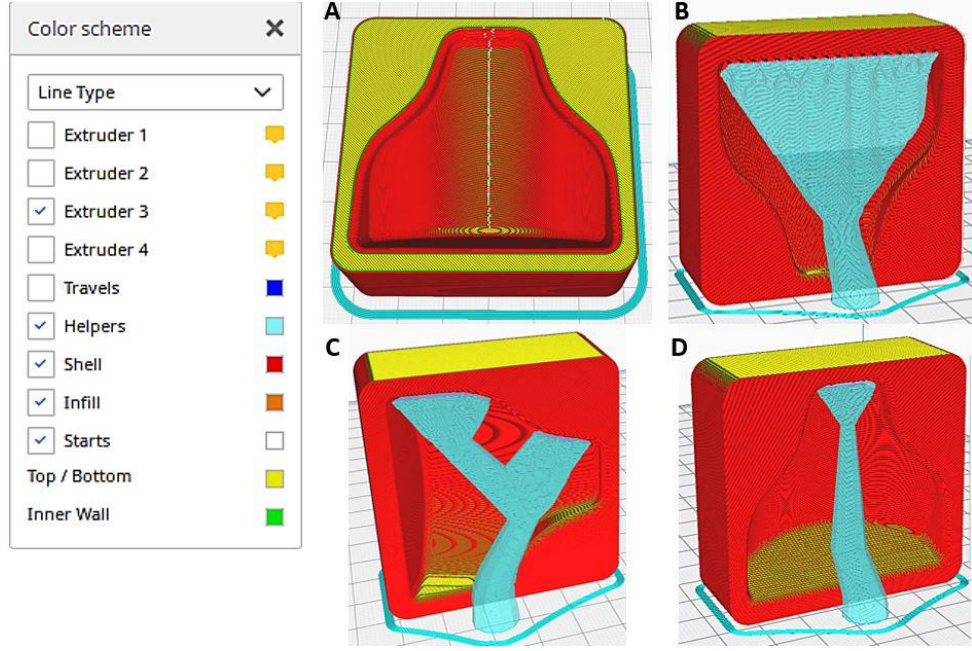
Figure 3. Part orientation on the buildplate, part helpers in blue.